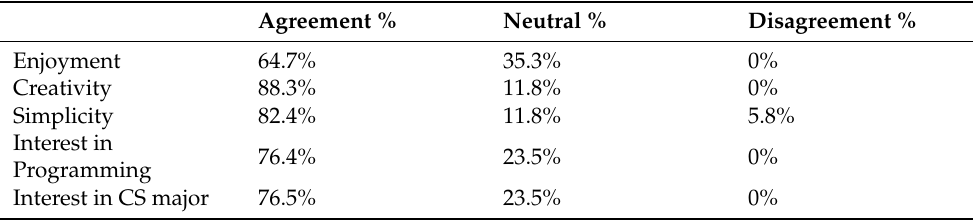
Table 2. Students’ responses to the survey questionnaire for the Mobile App Development course.